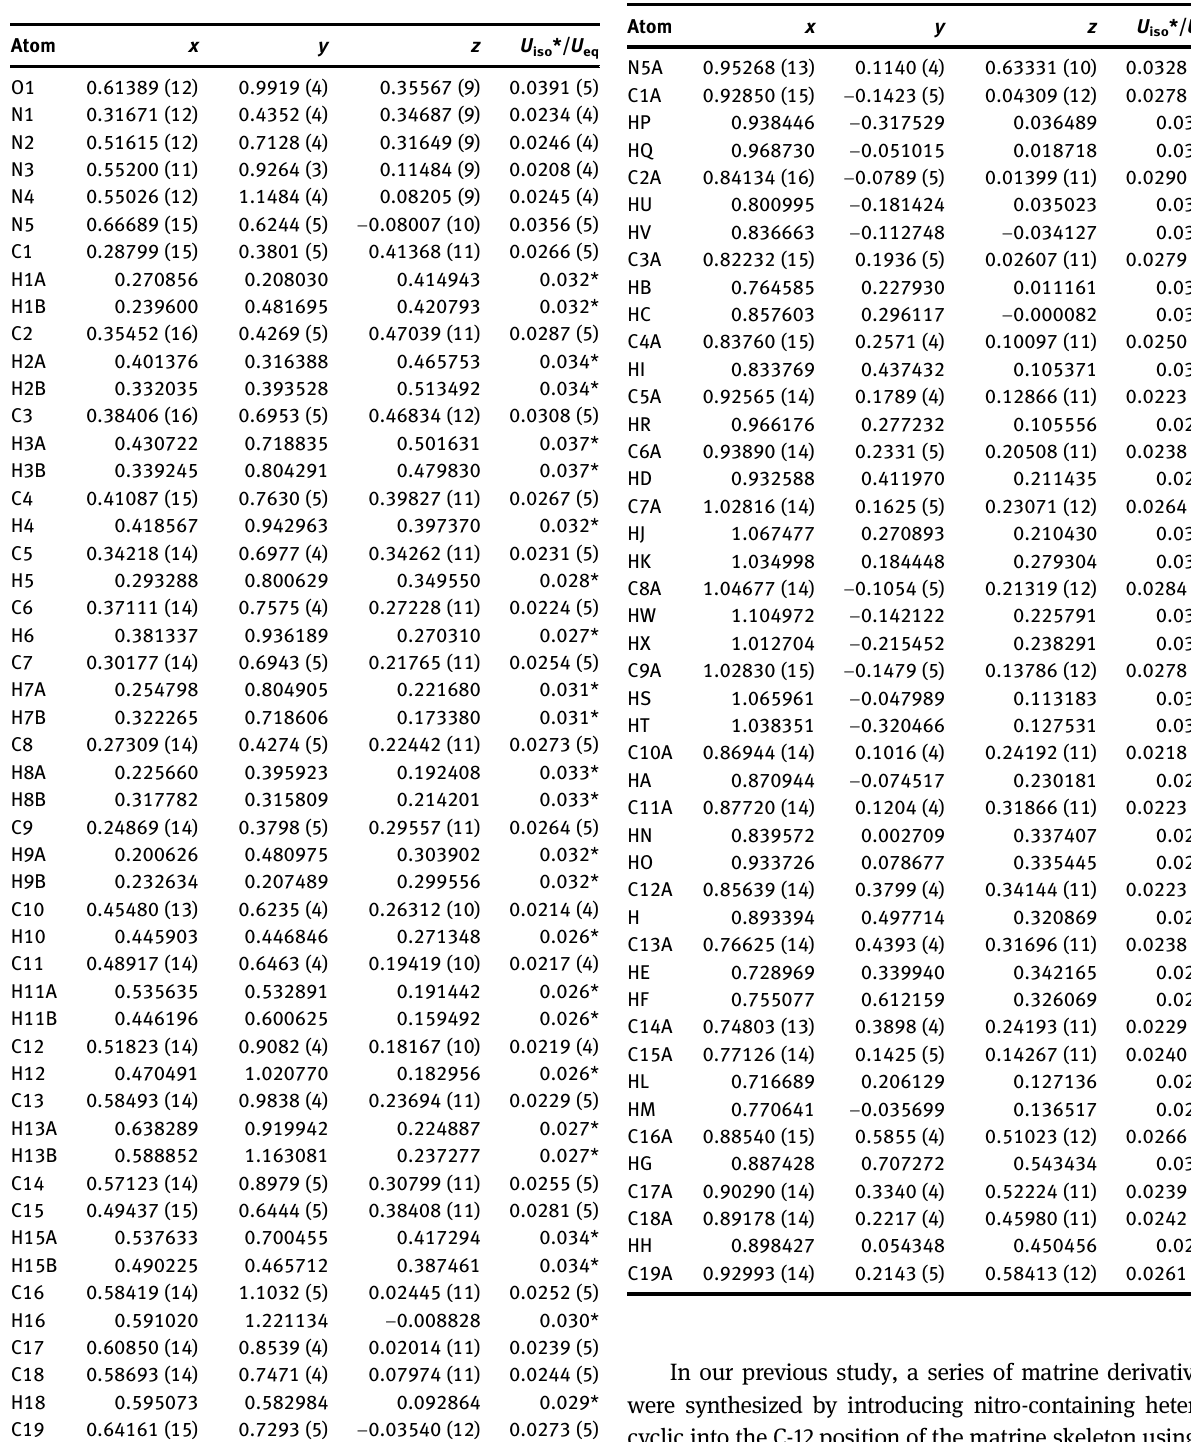
Table  : Fractional atomic coordinates and isotropic or equivalent isotropic displacement parameters (Å 